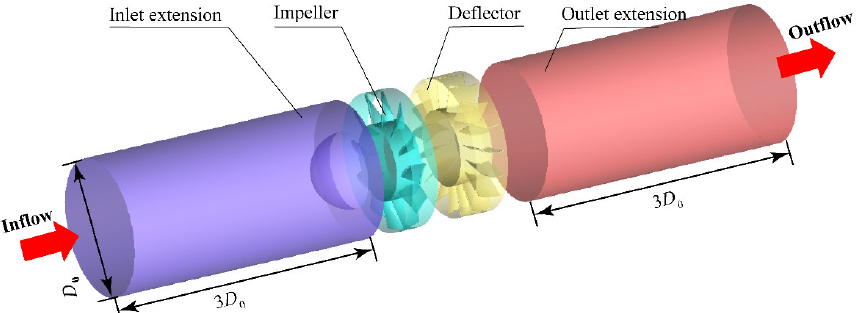
Figure 3. Computing domain of the axial flow fan.